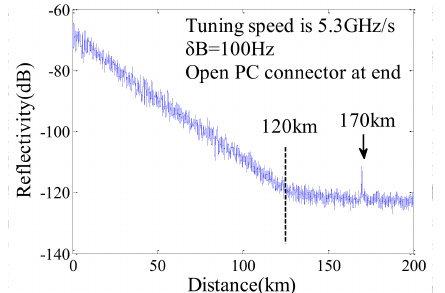
Figure 12. Measured Rayleigh backscattering and far-end Fresnel reflection trace from an open PC connector for 170 km. The range of Rayleigh backscattering is 120 km (reprinted from Ding et al. [16] with permission of IEEE; copyright